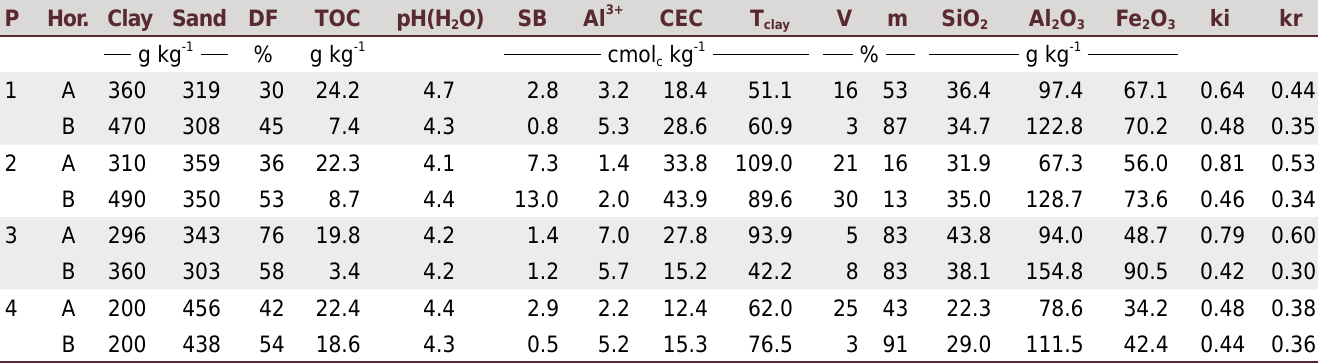
Table 2. Physical and chemical properties of A and B horizons of soil profiles from region I (sedimentary rocks), located in the municipalities of Urubici and Bom Retiro, SC, Brazil P Hor. Clay Sand